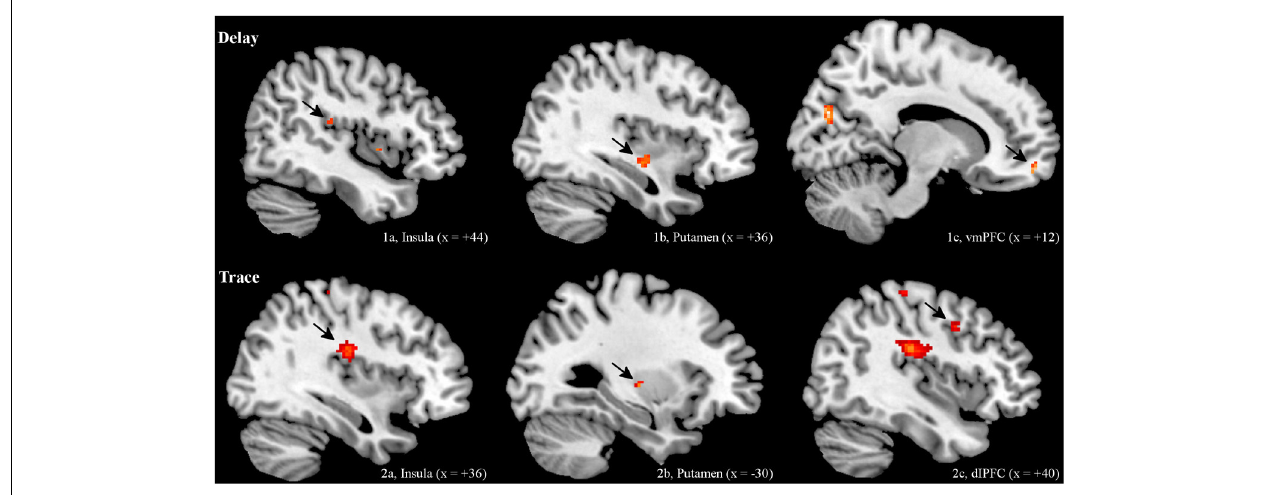
FIGURE 2 | BOLD Signals (CS + > CS − ) during early extinction (ROI, α < 0 . 005, uncorrected). In both DCG and TCG, Insula and Putamen were activated during early extinction. In the DCG, we